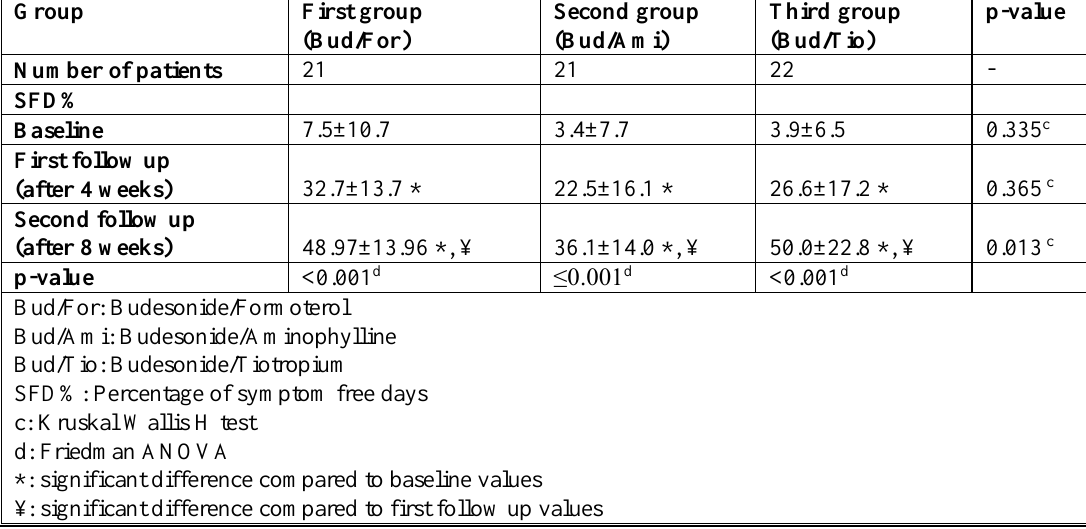
Table 5. Effect of study regimens on percentages of SFDs